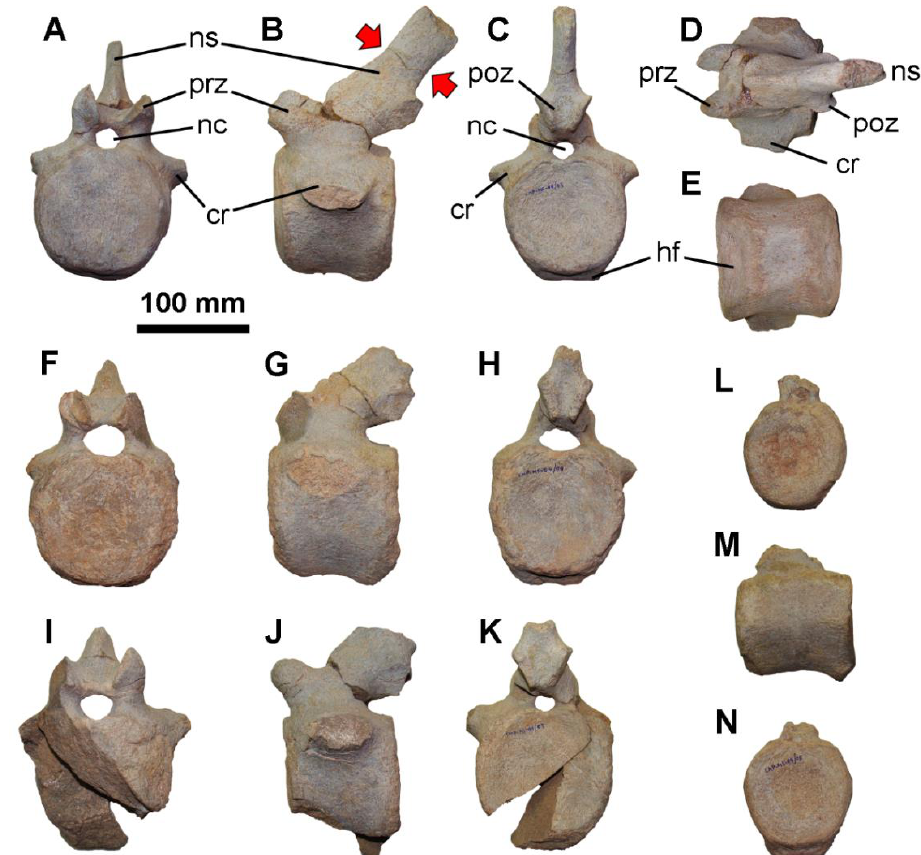
Figure 4. Caudal vertebrae of the specimen CMP-MS-04. CMP-MS-04/03 in anterior ( A ), left lateral, ( B ), posterior ( C ), dorsal ( D ), and ventral ( E ) views. CMP-MS-04/04 in anterior ( F ), left lateral, ( G ), and posterior ( H ) views. CMP-MS-04/07 in anterior ( I ), left lateral, ( J ), and posterior ( K ) views. CMP-MS-04/05 in anterior ( L ), left lateral, ( M ), and posterior ( N ) views. Abbreviations: cr, caudal rib; hf, haemal arch facet; nc, neural canal; ns, neural spine; poz, postzygapophysis; prz, prezygapophysis. Red arrows mark the distinctive character that assigned the specimen CMP-MS-04 to Iguanodon bernissartensis .